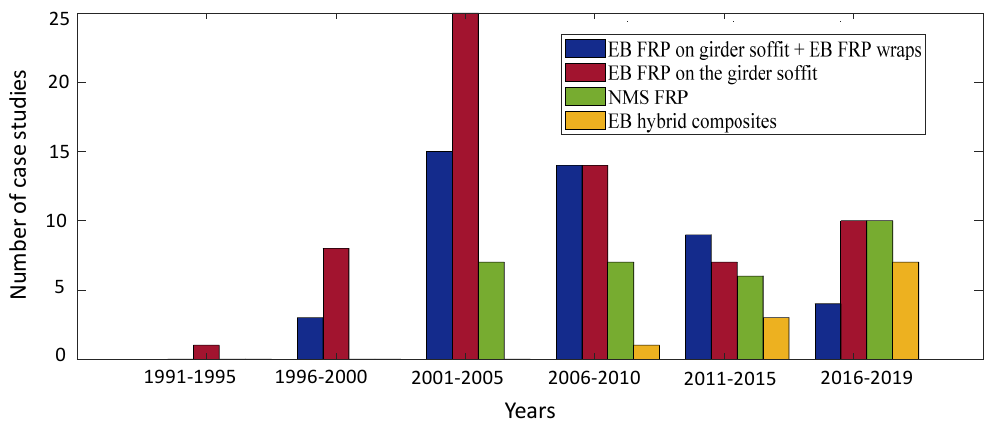
Figure 23. Evolution of case studies of the most common flexural bridge girder repair approaches over the past three decades.